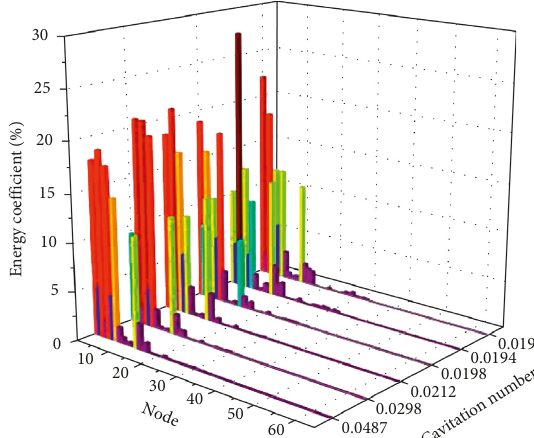
Figure 7: Energy coefficient under different cavitation numbers at rated flow